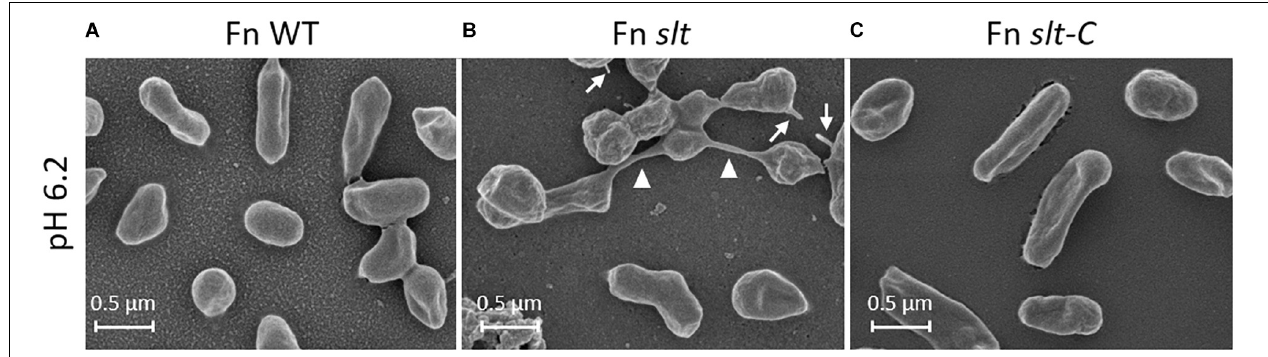
FIGURE 4 | Surface structure and morphology of Fn strains. Fn slt cells grown in CDM pH 6.2 show significantly ruffled surface structure and fusion of cells ( B , arrowheads), as well as tube-like surface projections ( B , arrows). Equal magnification images of Fn WT (A) and Fn slt -C (C) strains grown in CDM pH 6.2 show smooth surface appearance of cells and uniform appearance. Images were acquired under 30,000 × magnification; scale bar, 0.5 µ m.